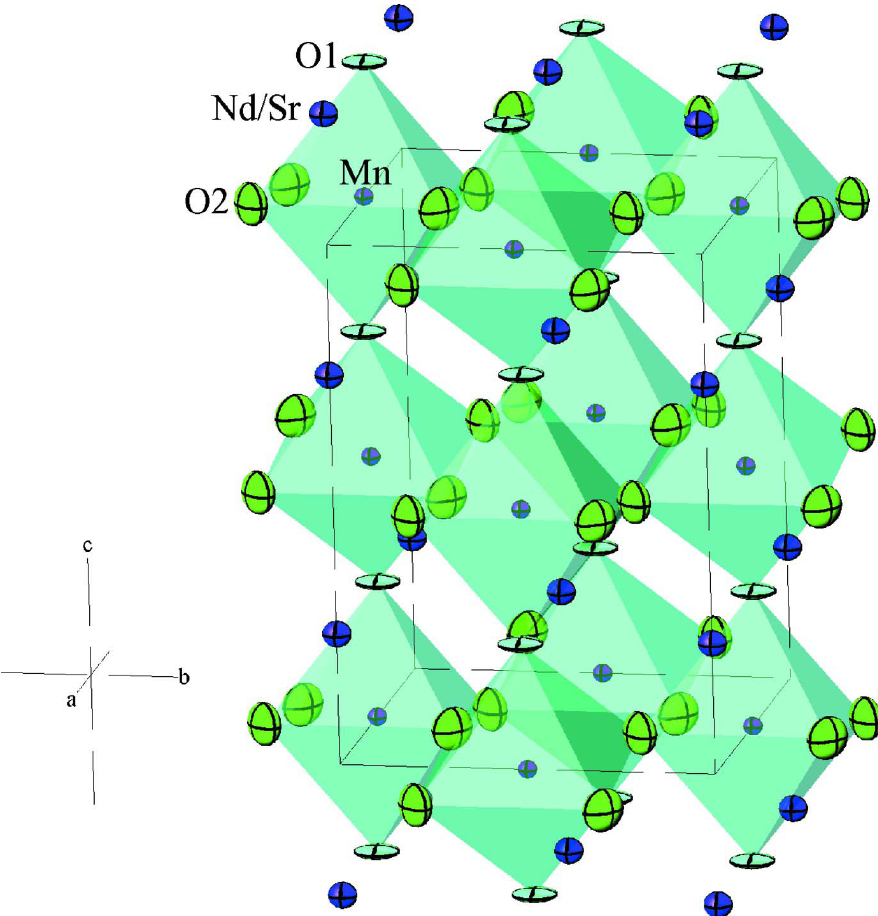
Figure 1 The structure of the distorted perovskite Nd